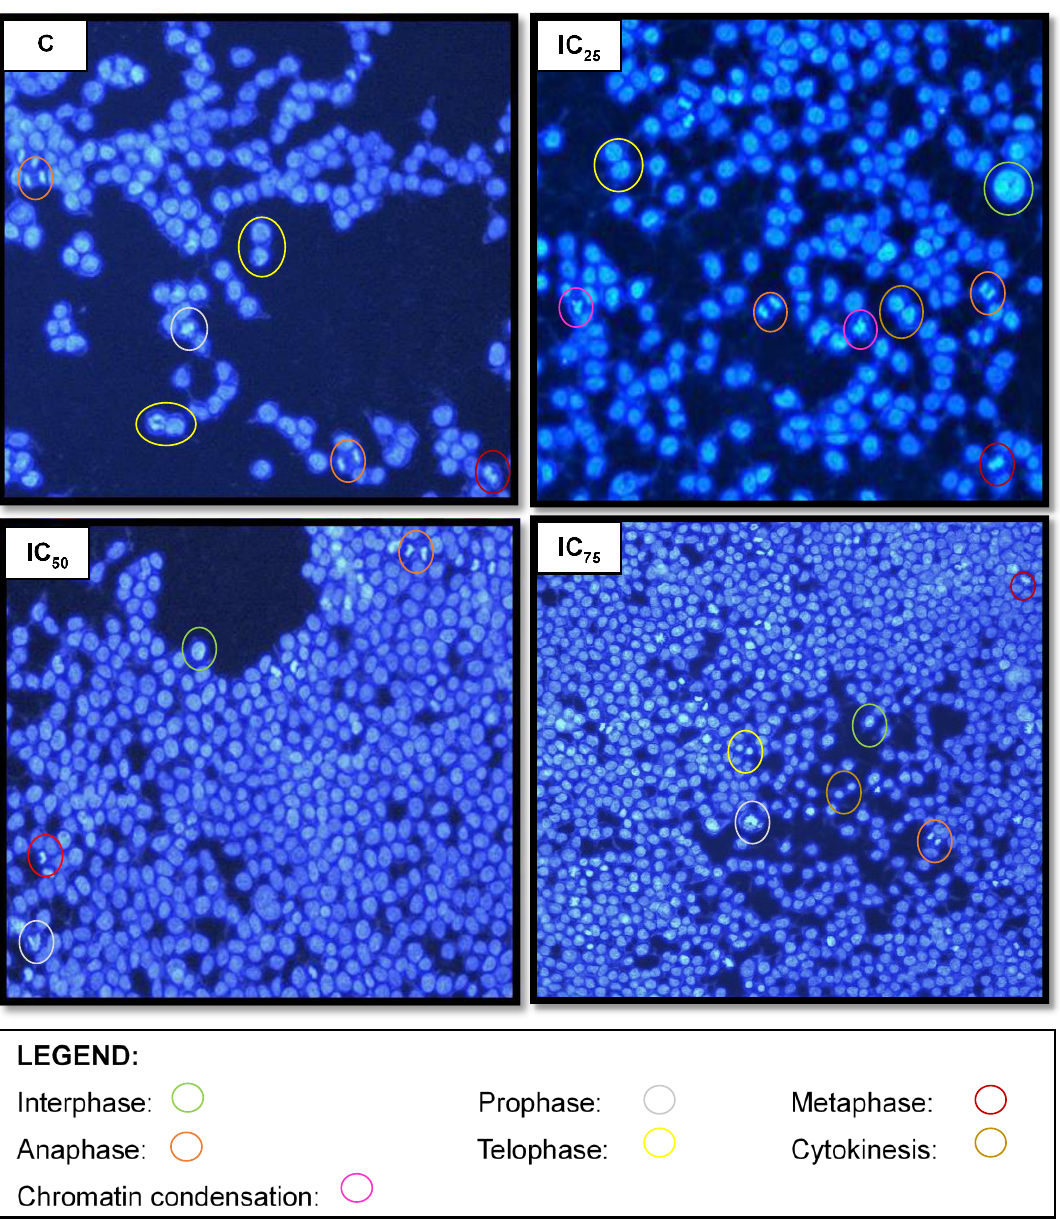
Figure 9. Nuclear arrangement and morphology of untreated Hek-293 cells vs. tannic acid treated Hek-293 cells (200×). Tannic acid induces proliferation in a concentration-dependent manner. C: control.